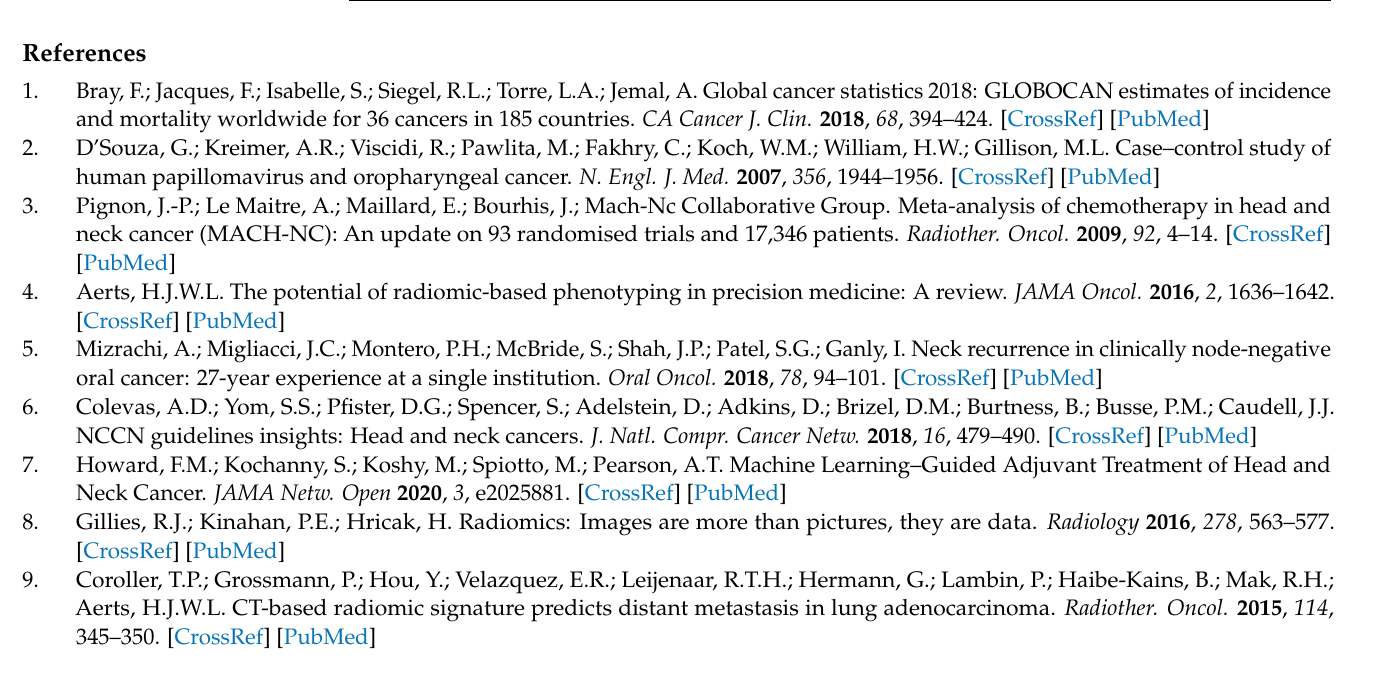
Table A1 (C) Top 10 Features of Figure